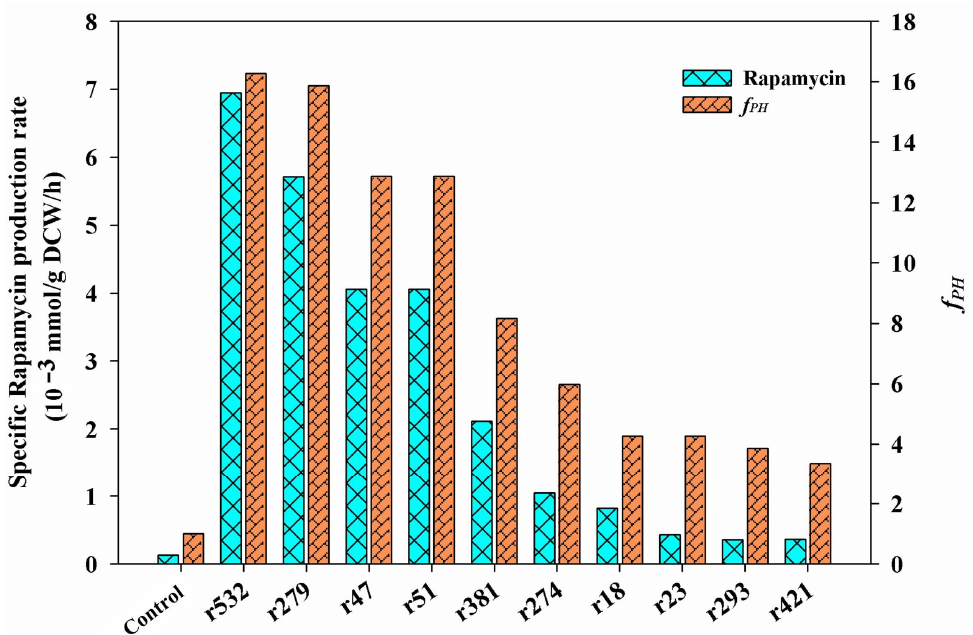
Figure 6. The predicted key limiting targets using GSMM model. According to the results of the metabolic characteristic analysis of each chemical elicitor treatment, all of the candidate targets were selected from the enriched metabolic pathways, including the central carbon metabolism, pyruvate metabolism, and the metabolism of several amino acids (i.e., phenylalanine, tyrosine and tryptophan biosynthesis, alanine, aspartate and glutamate metabolism, glycine, serine and threonine metabolism, valine, leucine, and isoleucine biosynthesis). Only the first ten targets are listed, and the detailed information of each target can also be seen in Table 2.